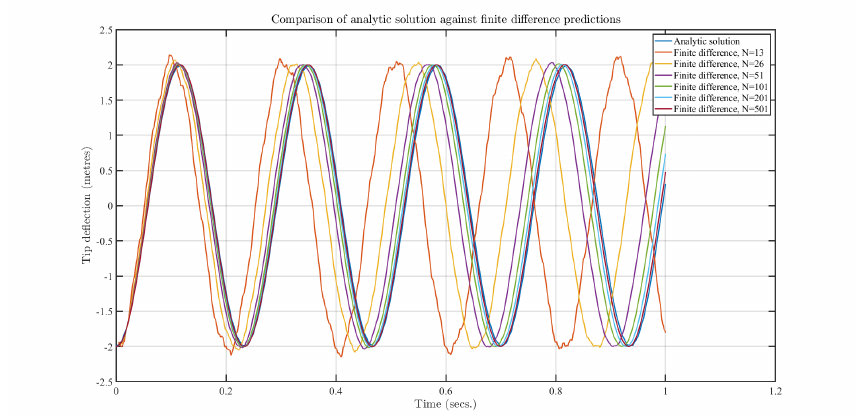
Figure 9. Comparison of the tip deflection between the analytical solution and finite difference predictions for a 10-m cantilevered beam in free